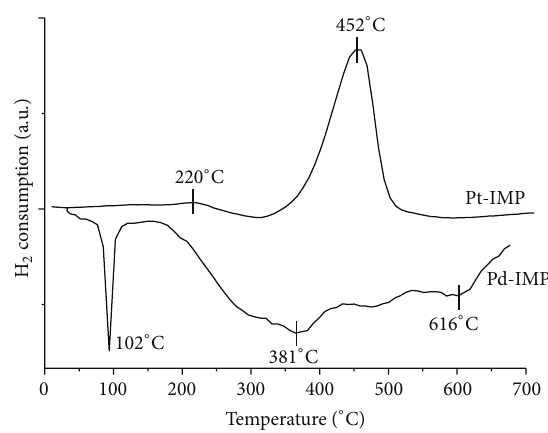
Figure 1: H 2 -TPR spectra of Al 2 O 3 -TiO 2 supported monometallic Pt-IMP and Pd-IMP